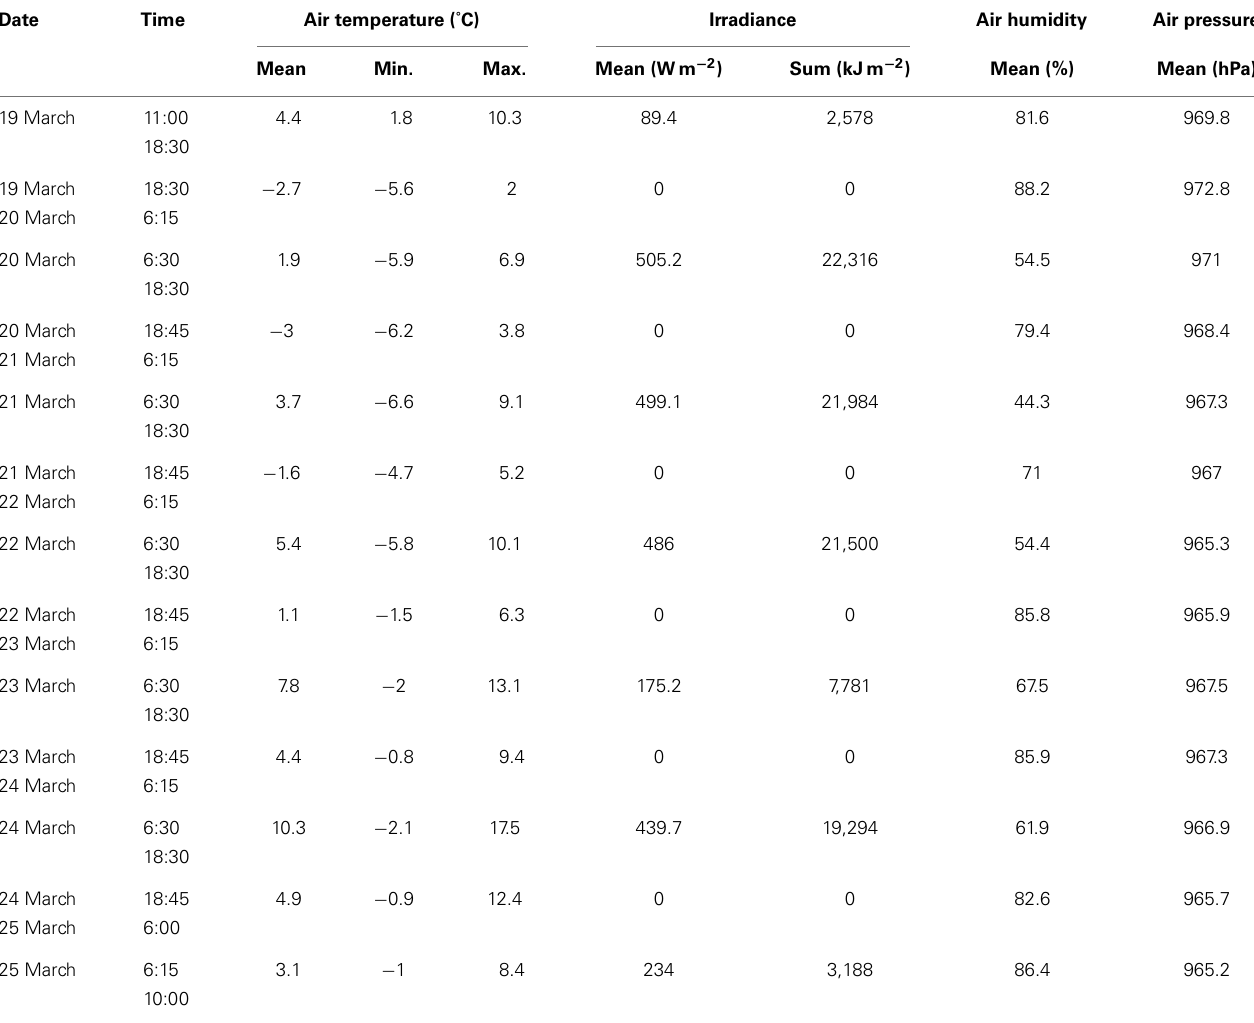
Table 3 | Summarized weather conditions during the out-door cultivation experiment (March 19–25,